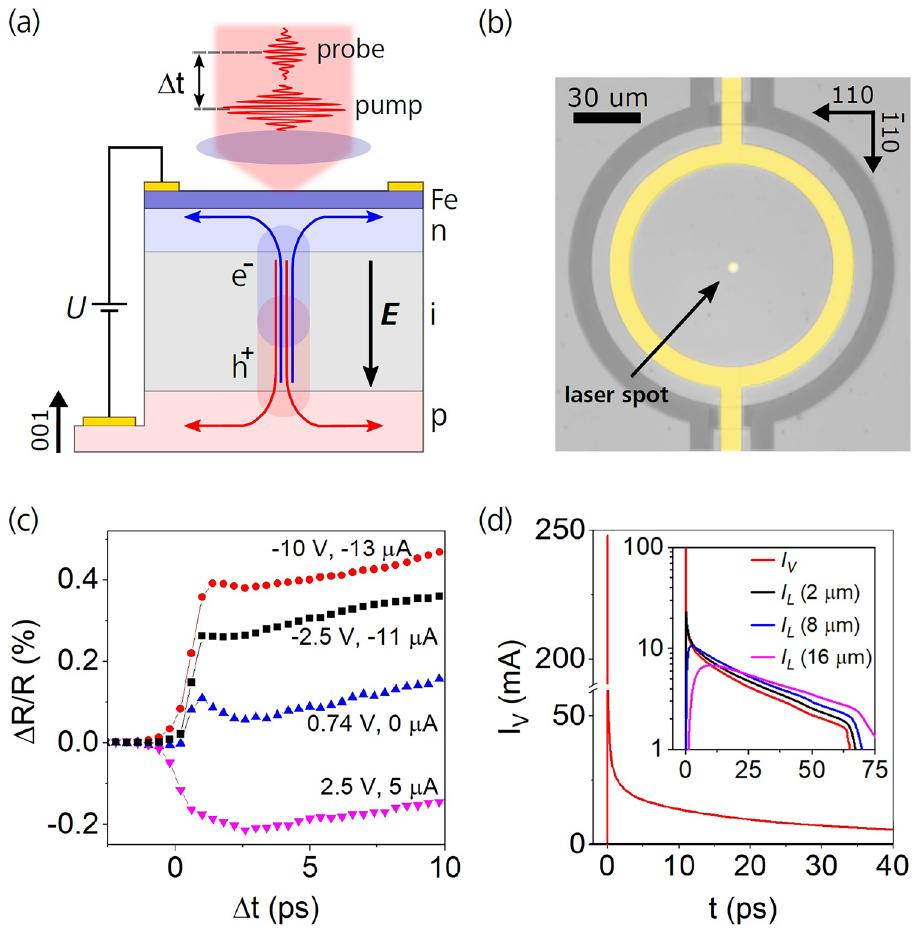
Figure 1. Device structure and properties of the photogenerated current pulses. ( a ) Schematic illustration of the GaAs p-i-n -diode structure with a thin ferromagnetic Fe film deposited directly on top of the diode. After an impact of a femtosecond laser pulse, a cloud of electron–hole pairs is generated. The electrons ( e − ) and holes ( h + ) are separated by a strong electric field E in the intrinsic layer ( i ) and accelerated towards the oppositely- charged electrodes creating a short current pulse, whose direction is schematically shown by arrows. To measure the dynamics of excited charge, spin and magnetization, a second time-delayed laser pulse can be used. (b) Micrograph of the photodiode lateral structure. The studied Fe/GaAs diode (light grey) is isolated from the rest of the sample by a trench (dark grey). The Fe film is electrically contacted by Au circular contact (yellow), which bridges the trench. The Au contact to the bottom p-GaAs electrode is outside of the displayed image. The bright spot in the image center is the focused laser spot. (c) Transient reflectivity measured in a pump-probe experiment for different applied bias voltages indicating the sub-picosecond photocurrent onset. The measured photocurrent averaged over the period of the stroboscopic experiment is shown for each bias. (d) Numerical simulation of the vertically propagating photocurrent pulse entering the n -GaAs/Fe electrode for an external bias of − 10 V. The initial current spike decays at a timescale comparable to the laser pulse duration of ≈ 100 fs. Inset: Comparison of the vertical current ( I V ) and the lateral current ( I L ) captured at various distances (2, 8, and 16 µm) from the injection point illustrating the pulse dispersion during its propagation through the device; note that logarithmic y -scale is used in the